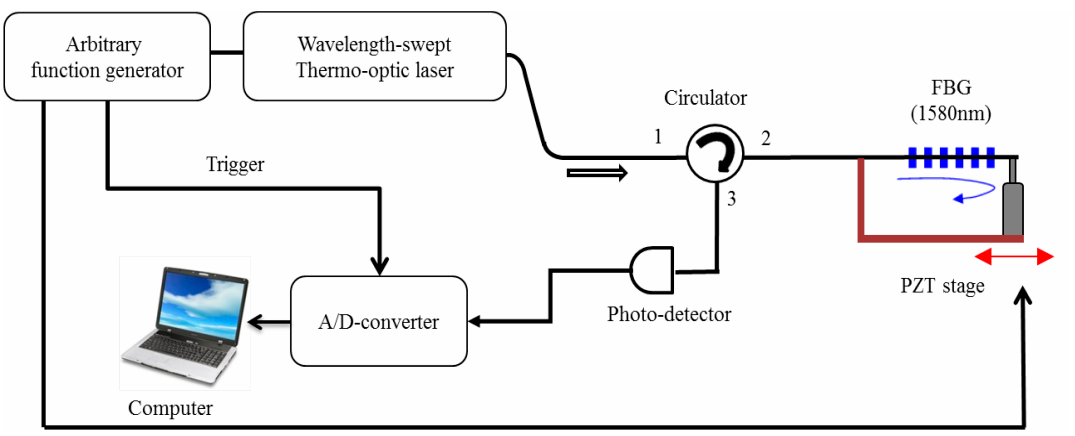
Figure 4. Experimental set-up for the FBG sensor interrogation system based on a linearized wavelength-swept thermo-optic laser